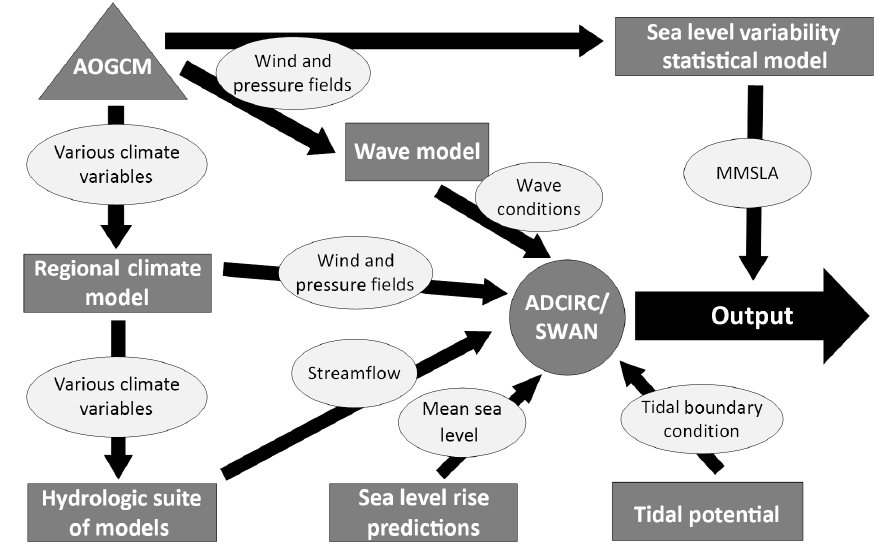
Figure 2. Overview of the general modeling framework. The dark gray triangle labeled AOGCM in the top left corner is the “parent” model. Dark gray rectangles represent sub-models. Light gray ovals represent variables that are passed between modeling